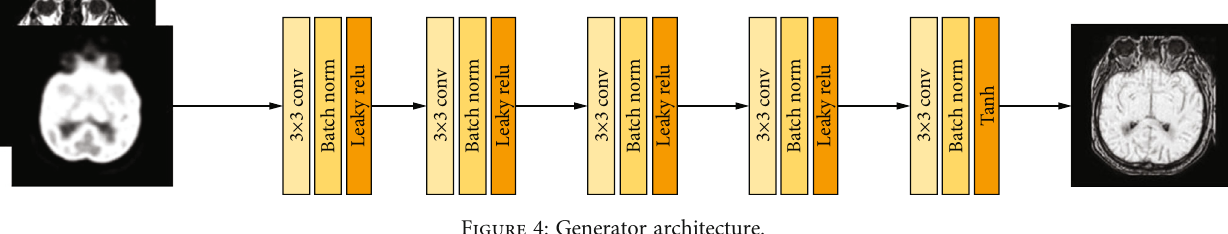
Figure 4: Generator architecture.